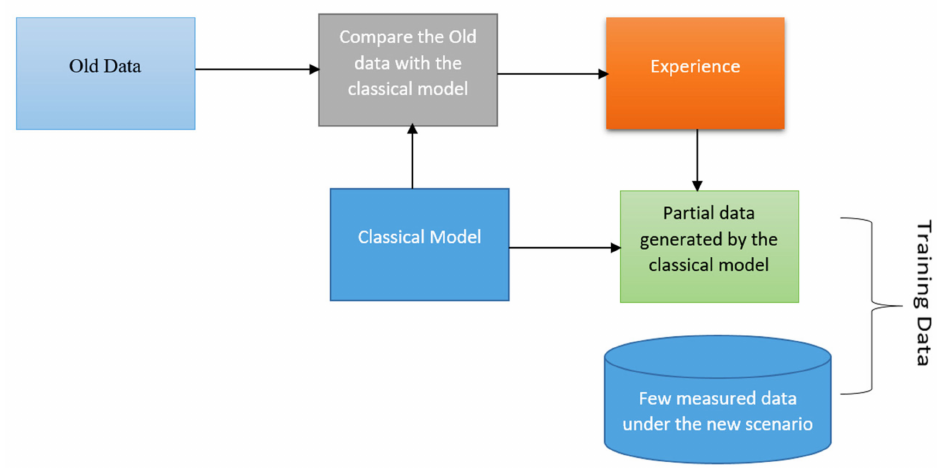
Figure 4. The proposed framework for data expansion using classical